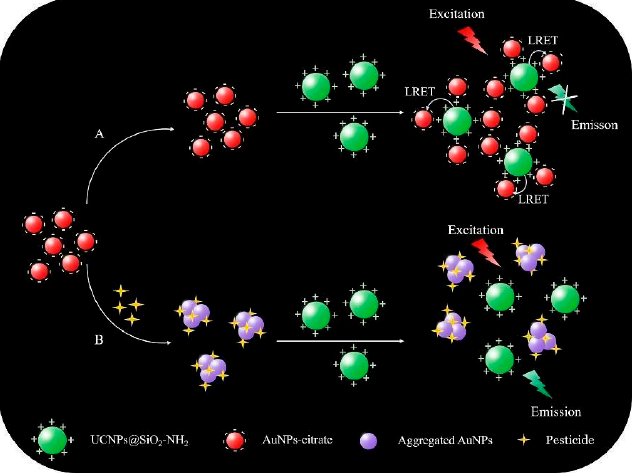
Figure 7. Schematic interpretation of the FRET method for the detection of cyano-containing pesti- cides. (Reprinted from reference [111] with permission from Elsevier).